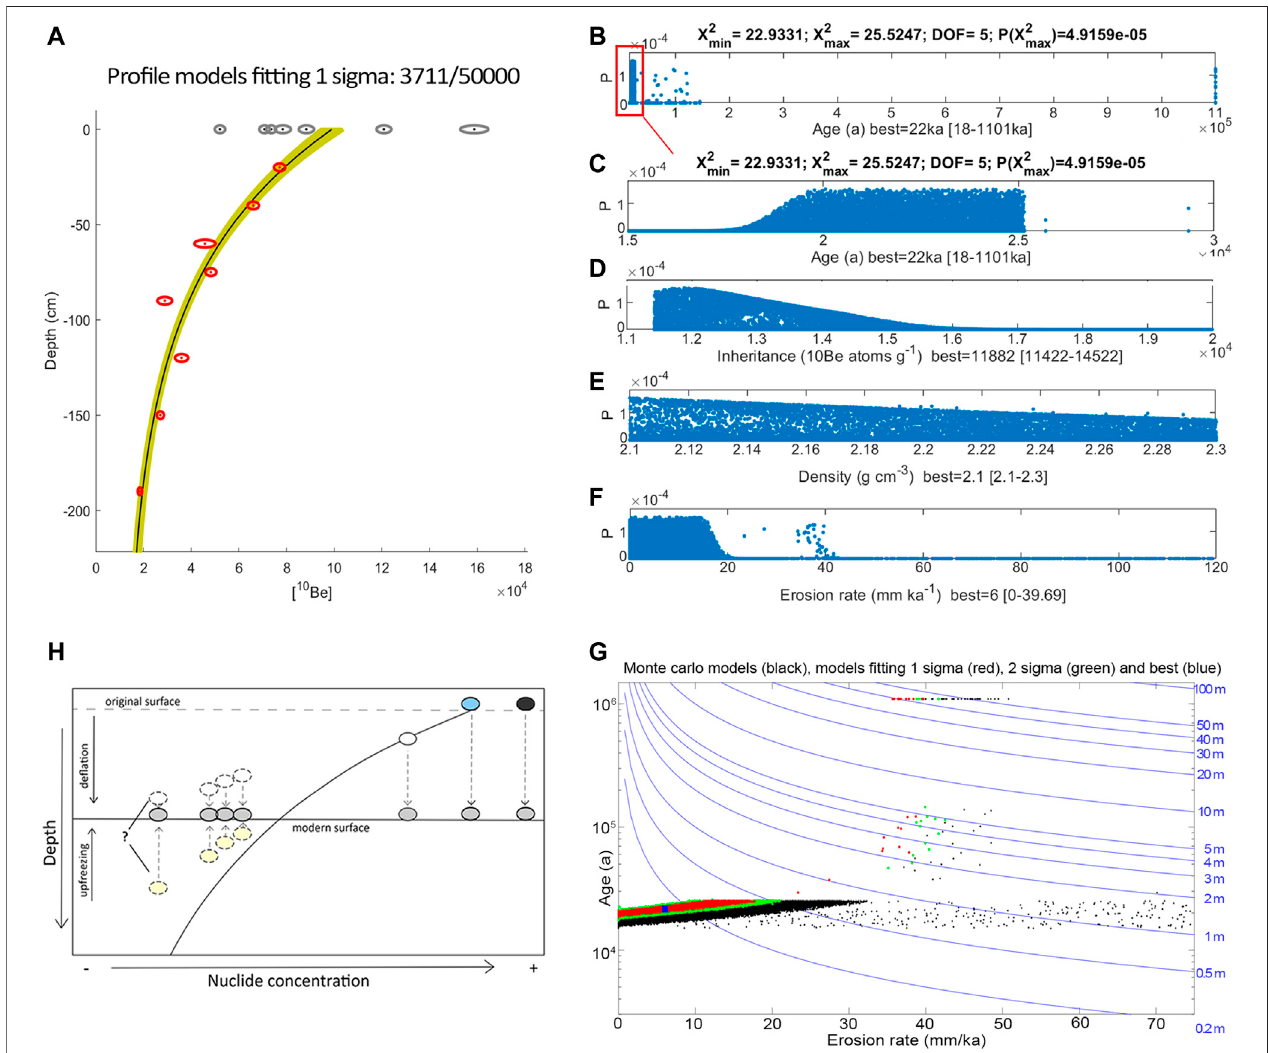
FIGURE9| Depth pro fi lemodelresults fromoutwashdeposit locatedinOtwayice lobe,associatedwiththesoutheastern LagunaBlancaspillway. (A) Plot of 10 Be concentrationofsamplesfromthesurface(greycircles)anddepthpro fi le(redcircles),withtheiruncertaintiesasafunctionofdepth.Greenlinesindicatethemodelresults that fi t within 1 sigma, the black line corresponds to the best fi t model. (B – F) Probability density distributions of the different outputs of the model: age, inheritance, density,anderosionrate. (B) Showsthemodelledagesplottedbetween0 – 1,101ka,whereas (C) showstheagesplottedbetween15 – 30 ka. (G) Graphicshowing relationship between age, erosion rate, and surface lowering. Red dots are model runs lying within 1-sigma of the data, green are those within 2-sigma, and black dots are other model runs. Model output shows 99.5% of data within 1-sigma lie within an age range of 18.6 – 25.1 ka, with a small component of well- fi tting model runs that wouldrequireimplausible(40 – 50 m)amountsofsurfacelowering. (H) Schematiccartoontoexplainscatteredageofthesurfacesamplesandreasonsfortheirdifference inagefromthedepthpro fi lemodelling.Theoldersamplescouldhavebeenexposedtothecosmogenicradiationfromtheoutwashterraceformation(bluesample).Ifthe sampleshaveacomponentofinheritancefromearlierexposure,thentheagewillbeolderthantheterrace(blacksample).Ade fl ationoftheoutwashwillexposesamples that were initially buried, resulting in younger than the outwash age (white). Younger samples could also be raised to the surface due to in fl ation processes, such as upfreezing (see Hein et al. (2009), and Darvill et al. (2015) for further discussion).